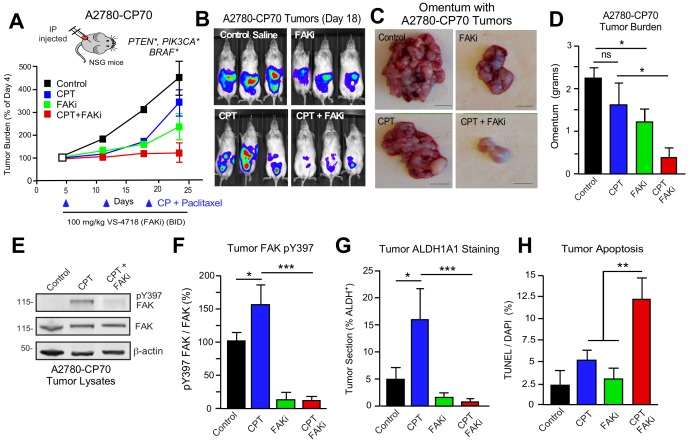
FAK inhibition sensitizes CP-resistant tumors chemotherapy-induced apoptosis.(A) Experimental schematic and IVIS imaging of labeled A2780-CP70 cells IP injected into NSG mice (randomized at Day 5). Experimental groups: control saline (black) injection on Days 5, 12, and 19; VS-4718 by oral gavage (green, 100 mg/kg, BID); CPT chemotherapy injection (blue, 3 mg/kg cisplatin and 2 mg/kg paclitaxel) on Days 5, 12, and 19; and VS-4718 plus CPT combined administration (red). IVIS imaging was performed on Days 4, 11, 18, and 23. Tumor burden is expressed as percent of Day 4. (B) Representative IVIS images of A2780-CP70 tumor burden on Day 18. (C) Representative images of omentum with A2780-CP70 tumors at Day 24. Scale is 0.5 cm. (D) Omentum-associated A2780-CP70 tumor mass (n = 6,± SEM *p<0.05, one-way ANOVA) from each treatment group. (E) A2780-CP70 tumor lysates immunoblotted for FAK pY397, FAK, and actin. (F) Ratio of pY397 FAK to total FAK levels in tumor lysates by immunoblotting. Values are means (± SEM *p<0.05, ***p<0.001, one-way ANOVA) of three tumors per experimental group. Control set to 100. (Gand H) Percent ALDH-1A1-positive immunofluorescent A2780-CP70 tumor staining or apoptosis (TUNEL and Hoescht 33342 staining) in A2780-CP70 tumors. Values are means (± SEM, two independent tumors, five random fields per tumor at 20X, *p<0.05, **p<0.01, ***p<0.001 one-way ANOVA).